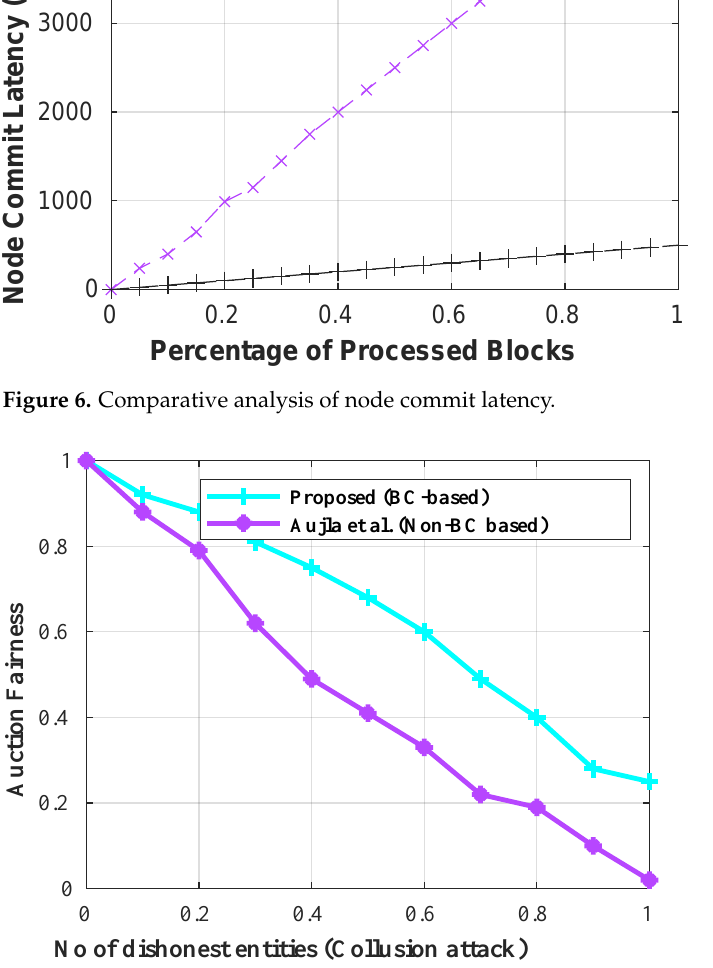
Figure 7. Comparative analysis of fairness in the auction